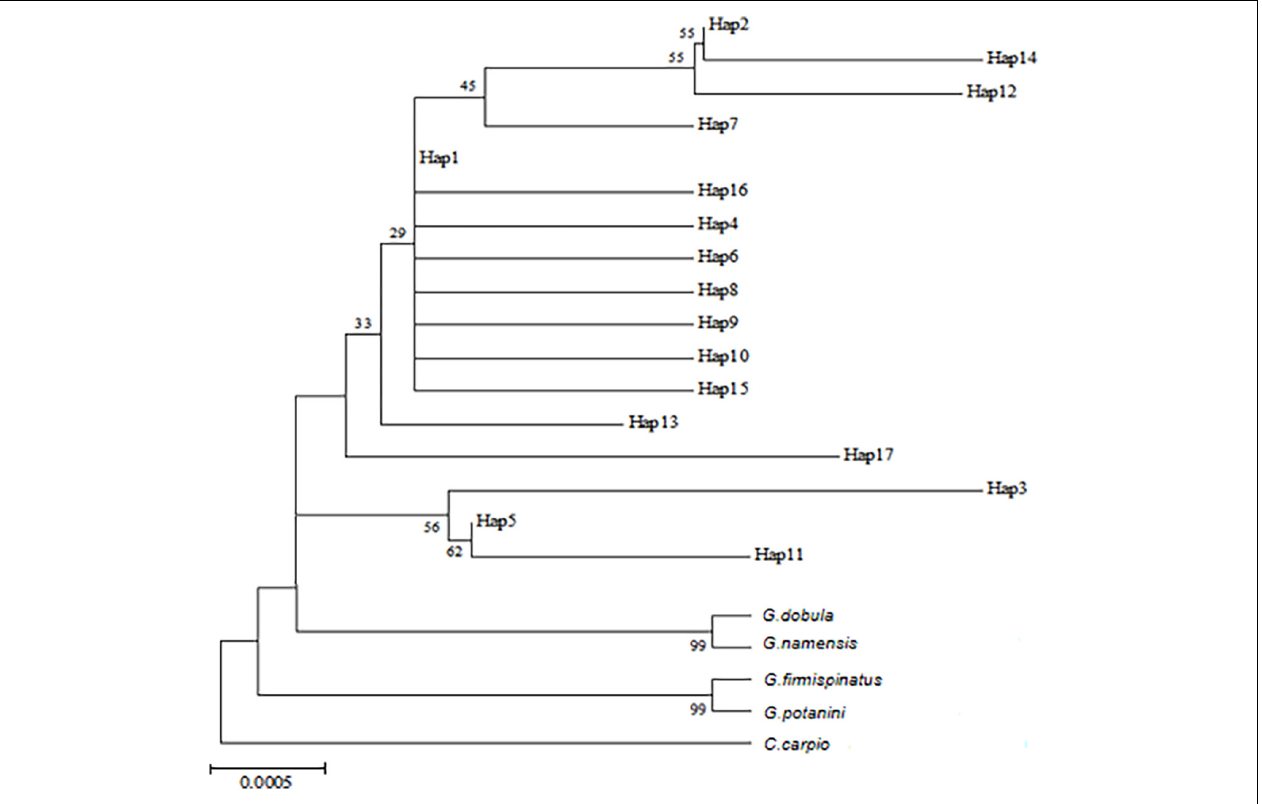
FIGURE 4 | NJ tree of COI gene of G. przewalskii based on Kimura-2-parameter model. Numbers at the nodes represent bootstrap